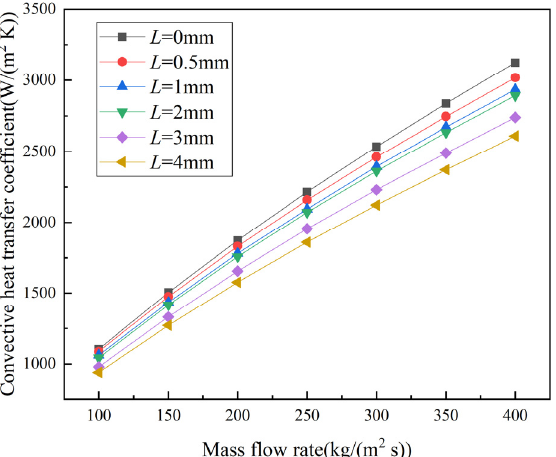
Figure 7. Convective heat transfer coefficient values of PCHEs at different mass flow rates for different offset distances of inserted straight sections.